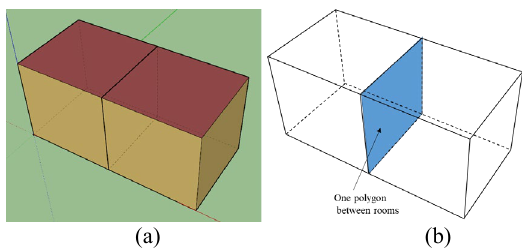
Figure 10. Scenario 1 result. (a) SketchUp visualization; (b) Schema